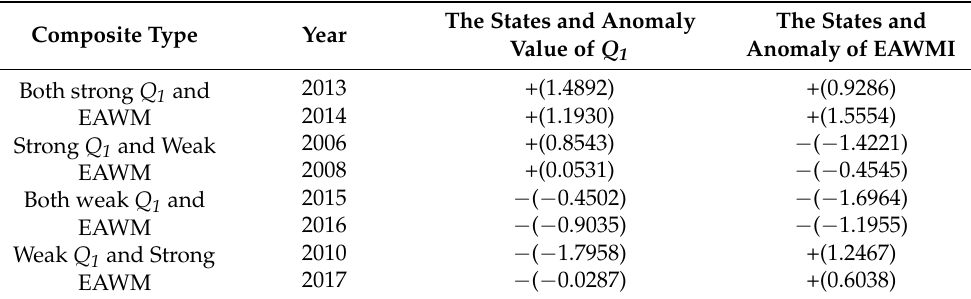
Table 1. Composite of different East Asian winter monsoons with strong or weak cold sources over Tibetan